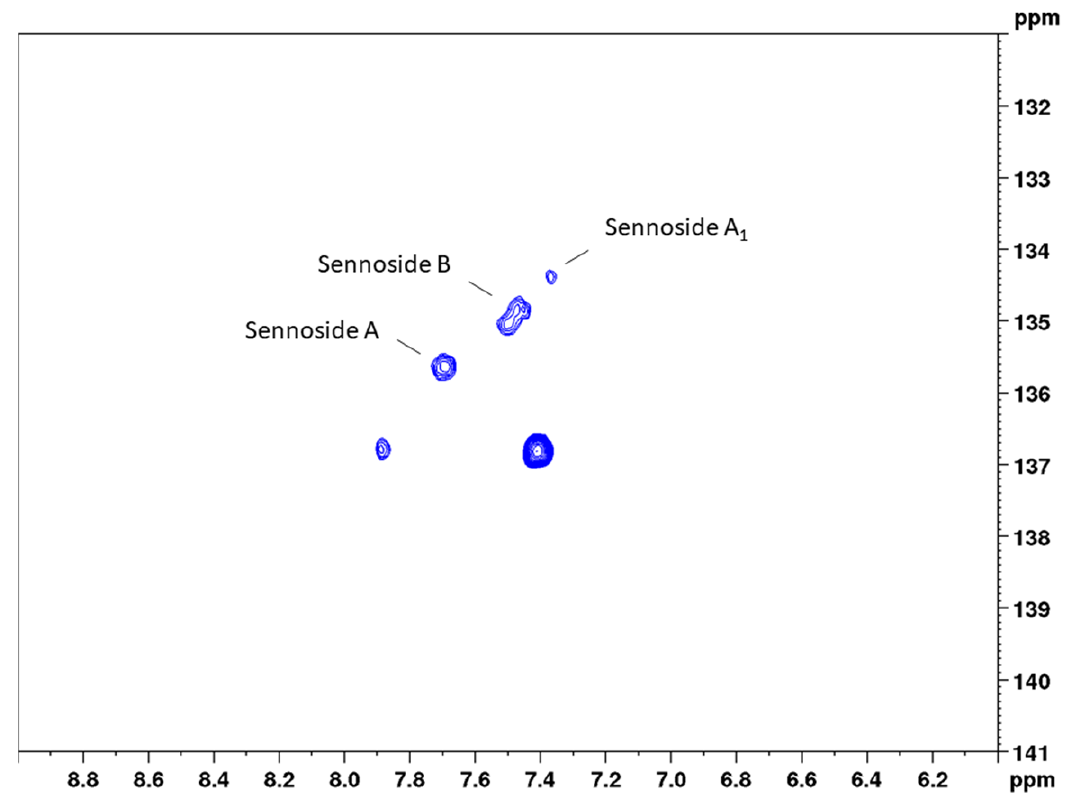
Figure 6. Band-selective HSQC diagram of senna solid-phase extract (1 g pods) in DMSO- d 6 with delays optimized for 163 Hz in the range of 6.0 to 9.0 ppm ( 1 H) and 131 to 141 ppm ( 13 C).